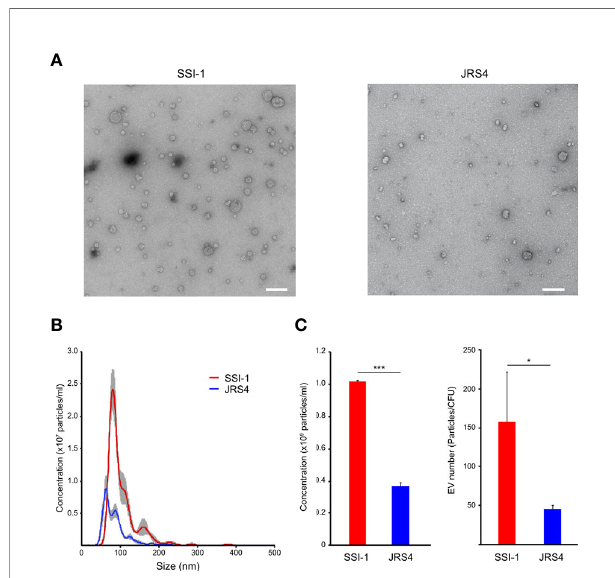
FIGURE 1 | Observation and quanti fi cation of EVs released from S. pyogenes str. SSI-1 and JRS4. (A) Extracted EVs were negatively stained and visualized by TEM at on original magni fi cation of 30,000. Scale bars, 200 nm. (B) Quanti fi cation and size distribution of S. pyogenes EVs were analyzed using NanoSight. (C) Concentrations (particles/ml) and EV numbers (particles/ CFU) were calculated from the NanoSight data and are shown in the left-hand and right-hand panels, respectively. All experiments were performed in triplicate. Data in B represent the mean ± SEM of independent experiments. P-value calculated by two-tailed Student's t-test. *P < 0.05, ***P <